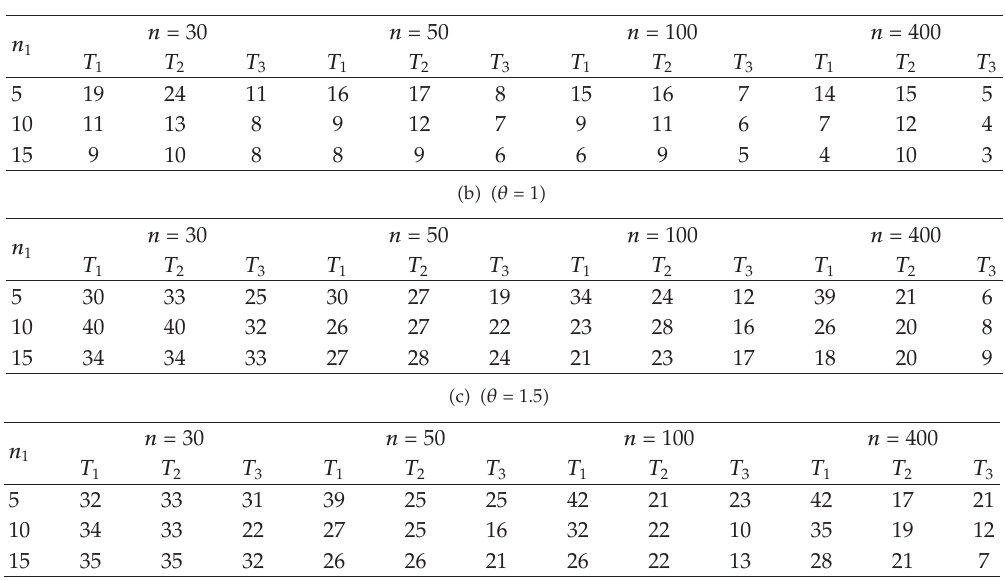
Table 1: Integrated absolute di ff erence of the cumulative distributions (cid:7) × 100 (cid:8) of T 1 ∼ N (cid:7) 0 ,M − 1 (cid:7) ξ ∗ ,θ (cid:8)(cid:8) , ∼ N (cid:7) 0 ,M − 1 (cid:7) ξ A ,θ (cid:8)(cid:8) , and T ∼ UQ versus the approximate cumulative distribution of T 2 3 via Monte Carlo simulations for various n 1 and various moderate sizes of n . The values θ (cid:6) 1, x 1 (cid:6) 2, σ (cid:6) . 5, a (cid:6) . 25, and b (cid:6) 4 were